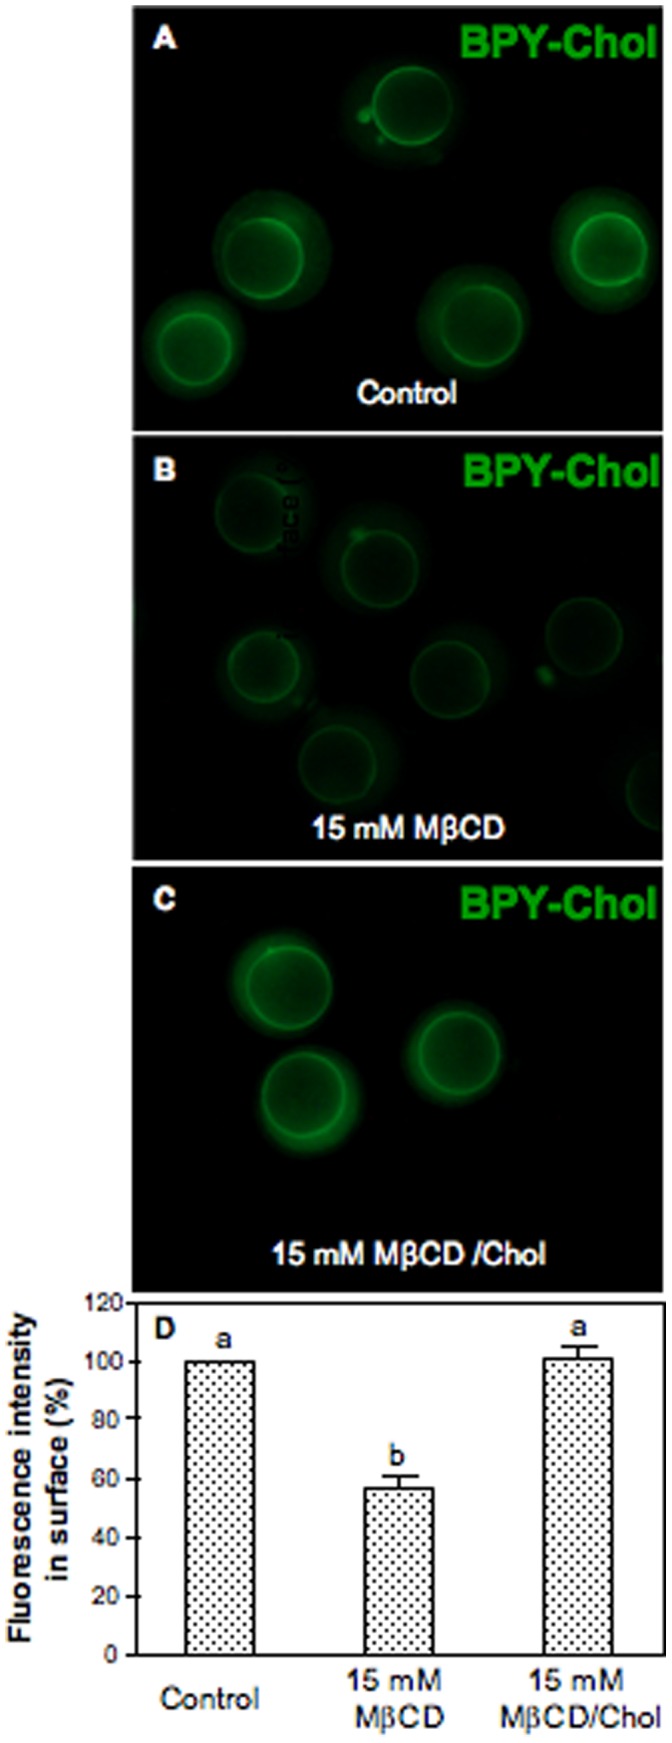
Effect of cholesterol depletion and repletion on oocyte cholesterol content.Zona-intact ovulated oocytes were pretreated with 15 mM MβCD for 30 min at 37°C to remove cholesterol. Cholesterol repletion was carried out incubating MβCD-treated oocytes with MβCD/Chol complexes. After depletion/repletion treatment, oocytes were washed and incubated with BPY-Chol for 15 min at 37°C. (A) Control, (B) depleted and, (C) depleted/repleted oocytes labeled with BPY-Chol. (D) Fluorescence intensity quantified with ImageJ software. Bars represent the mean ± SEM of 3 independent experiments from a total of 14 control oocytes, 23 depleted oocytes, and 17 depleted/repleted oocytes. Comparison of mean values was performed using Bonferroni test. Different letters (a-b) denote significant differences (P<0.05).